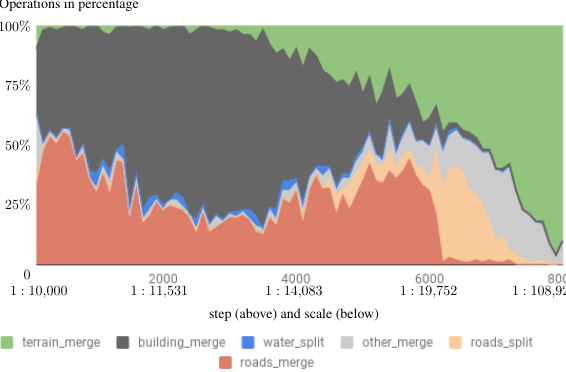
Figure 5. The percentages of operations executed per 100 steps in the tGAP creation process.